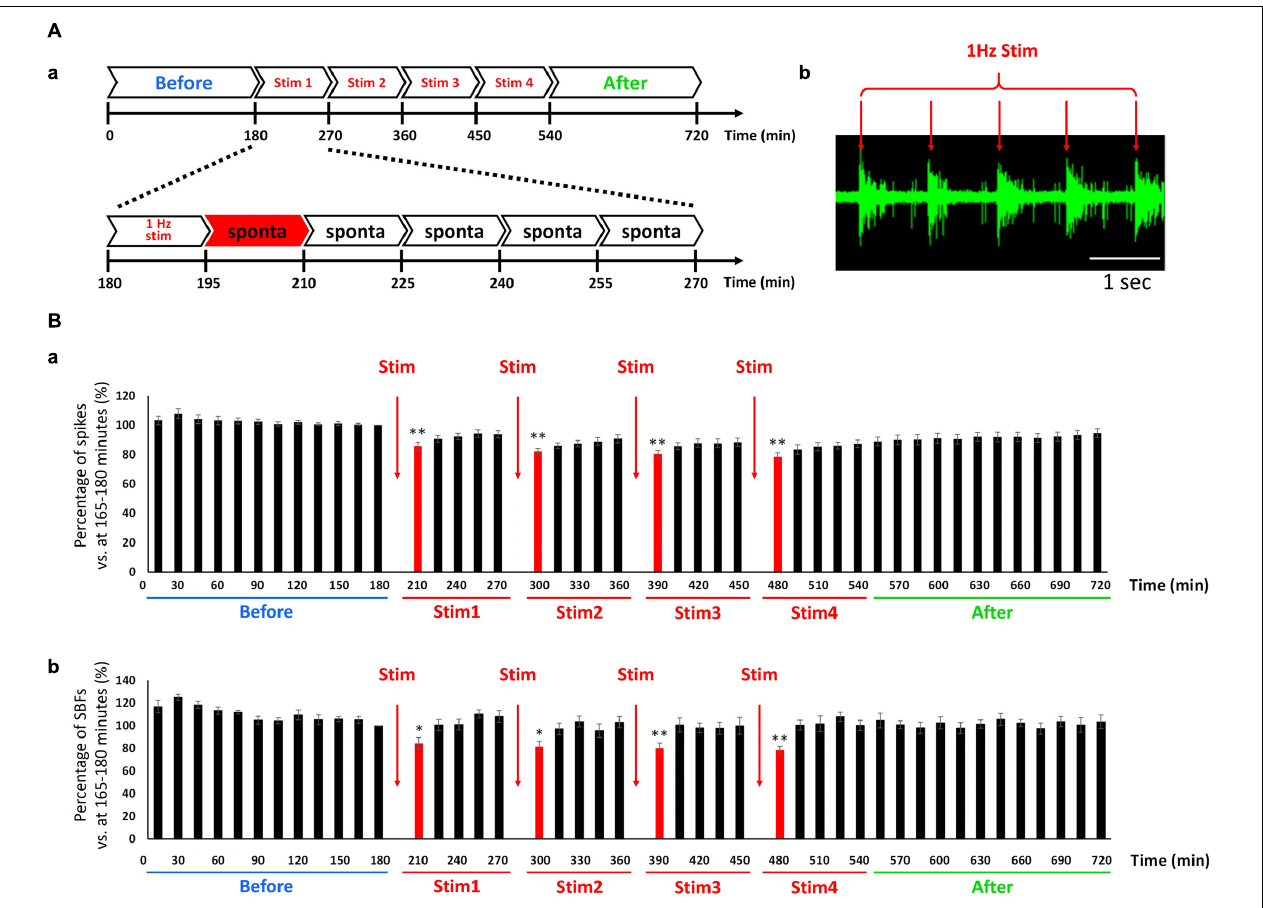
FIGURE 5 | Change in the spontaneous firings via low frequency electrical stimulation (LFS) in cultured hiPSC-derived glutamatergic neurons. (A) Outline of experiment. (a) First, spontaneous activity was measured for 3 h before feeding the electrical stimulation (blue: before). The stimulus set (single set = 90 min) was subsequently fed to the network four times (red: Stim 1–4). The first 15 min of each set entailed electrical stimulation at 1 Hz and the remaining 75 min entailed the measurement of spontaneous activity. After performing four sets of stimulations (Stim 1–4), spontaneous activity was measured for 3 h (green: after). (b) Typical evoked responses during LFS. Scale bar = 1 s. Red arrow shows stimulus time and stimulation artifacts. (B) Change in the spontaneous firings after LFS at 6 WIV ( n = 8). Black bars show the data for every 15 min, and red bars show the data for 15 min immediately after LFS. (a) Number of spikes vs. 165–180 min (%). (b) Number of SBFs vs. 165–180 min (%). Data were analyzed using one-way ANOVA followed by post hoc Dunnett’s test ( ∗ p < 0.05, ∗∗ p < 0.01 vs.